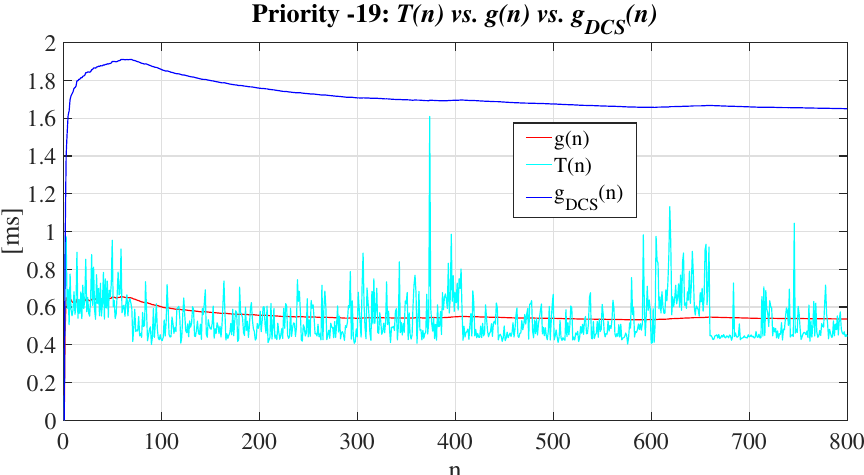
Figure 19. Temporary computational complexity analysis of the real-time quadrotor simulation algorithm using priority −